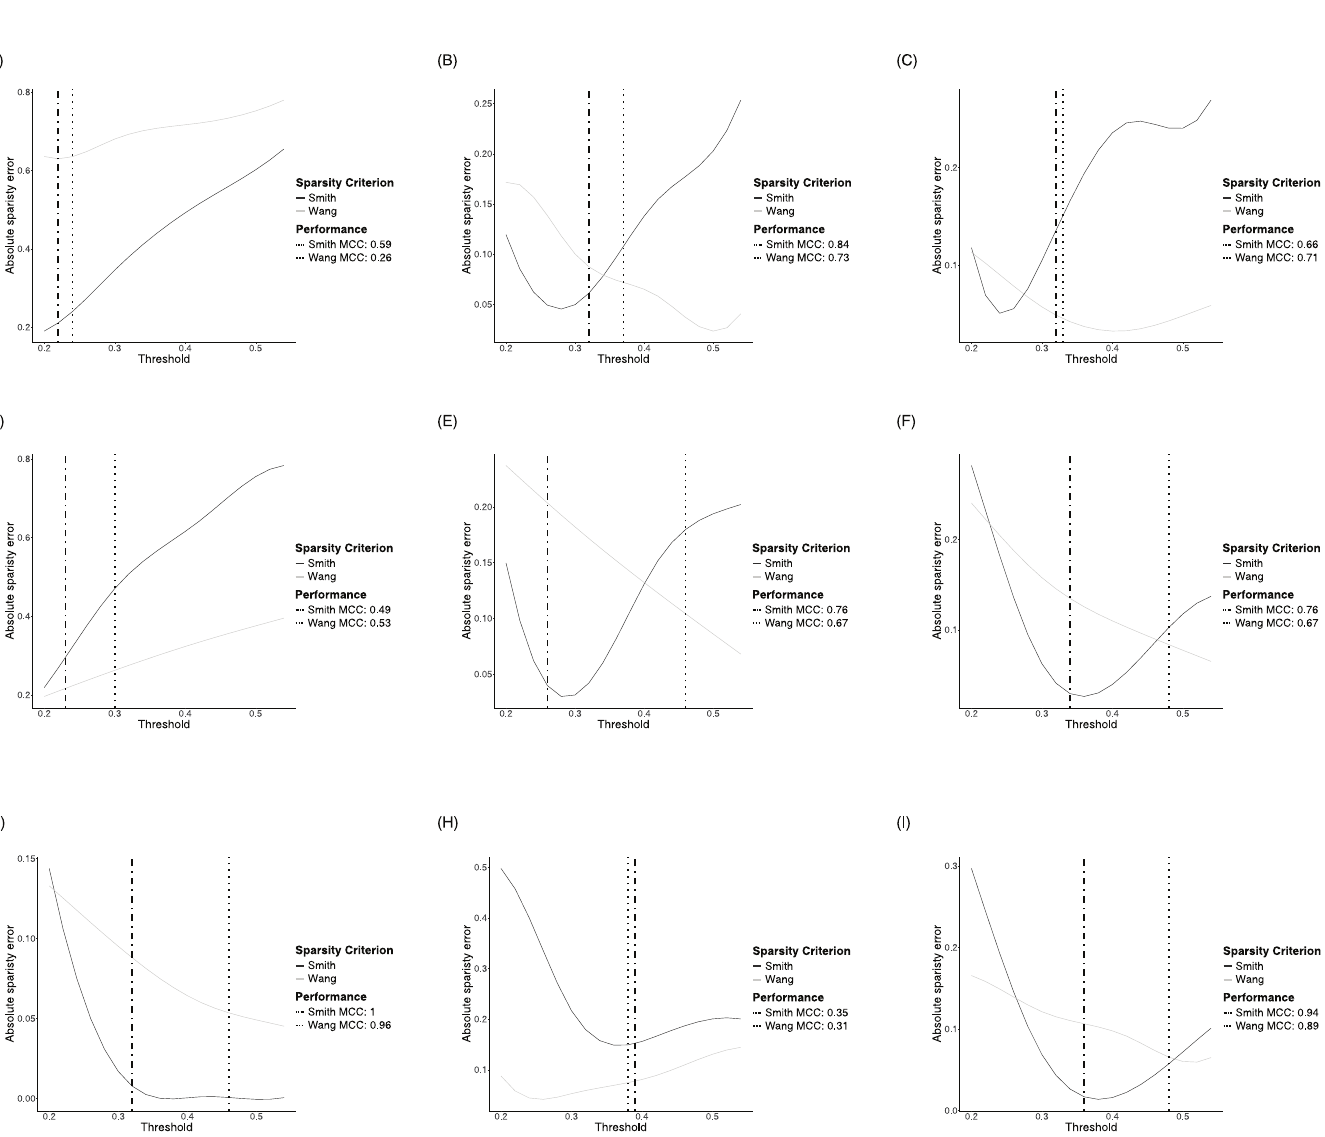
Fig 1. Optimal Bayesian sparsity threshold selection. The median of the absolute sparsity error and best performing MCC for various graph structures under varying thresholds for each Bayesian sparsity criterion in Eq (9) (dotted) and Eq (8) (dot-dash) for dimension p = 10. The best performing threshold is indicated by a vertical line with the accompanying MCC value displayed in the legend. (a) Model 1: AR(1). (b) Model 2: AR(2). (c) Model 3: at most 80% sparse. (d) Model 4: at most 40% sparse. (e) Model 5: scale-free. (f) Model 6: band. (g) Model 7: cluster. (h) Model 8: star. (i) Model 9: circle.